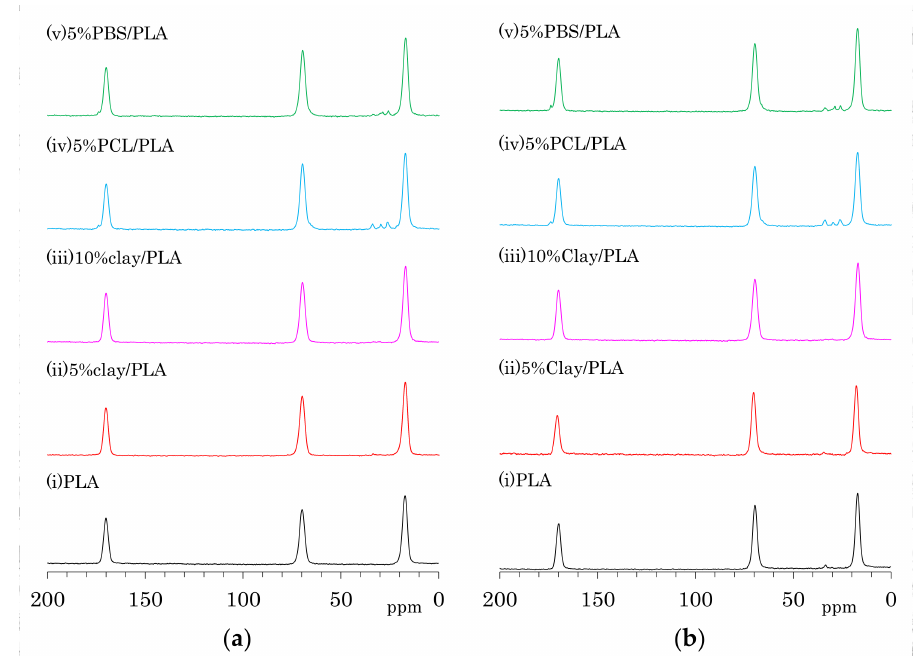
Figure 4. 13 C CP-MAS NMR spectra of PLA compounds: ( a ) before drawing; ( b ) after drawing at a draw ratio of